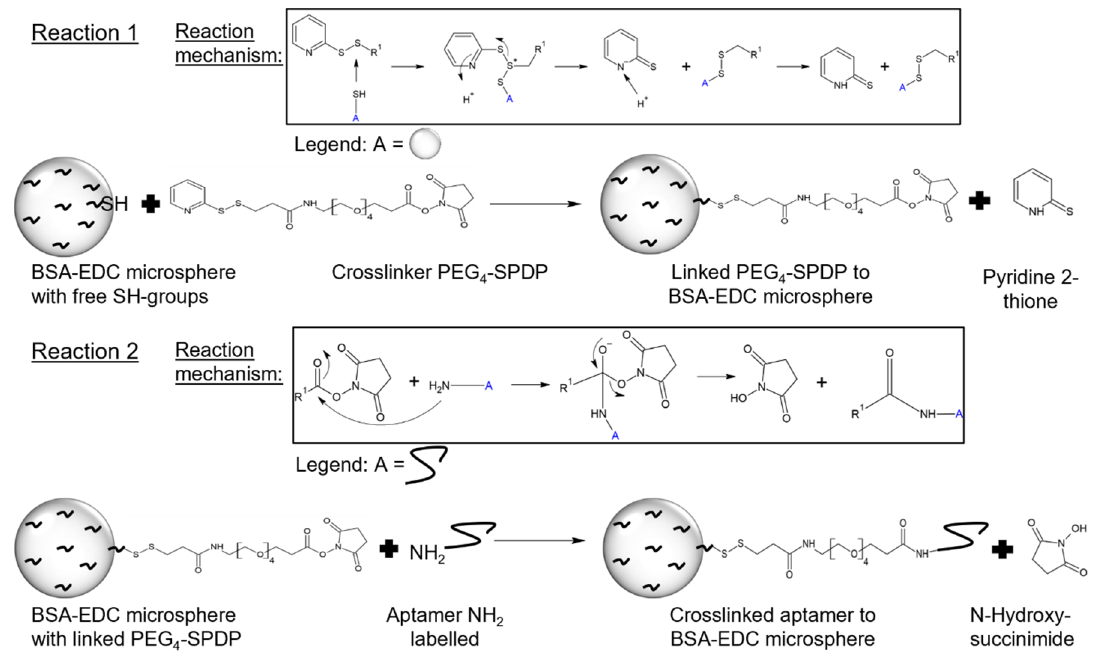
Figure 2. Functionalization of BSA hydrogel beads to aptamer capture beads (ACBs) with PEG 4 -SPDP- and NH 2 -labeled aptamer. The first reaction step is a displacement reaction of the sulfhydryl-reactive molecule (2-pyridyldithio group) of PEG 4 -SPDP with the free SH group of the BSA-EDC bead. In the second functionalization step, the NH 2 -labeled aptamer reacts with the amine-reactive portion ( N -hydroxysuccinimide) of PEG 4 -SPDP via an NHS ester reaction [24].